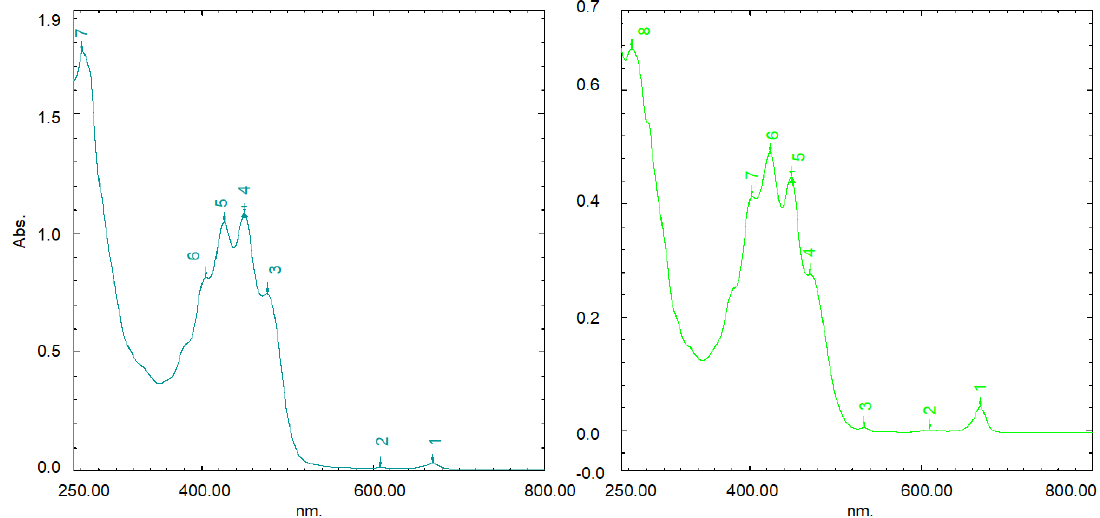
Figure 4. The typical UV-VIS spectrum of carotenoid interference between 390 and 480 nm.